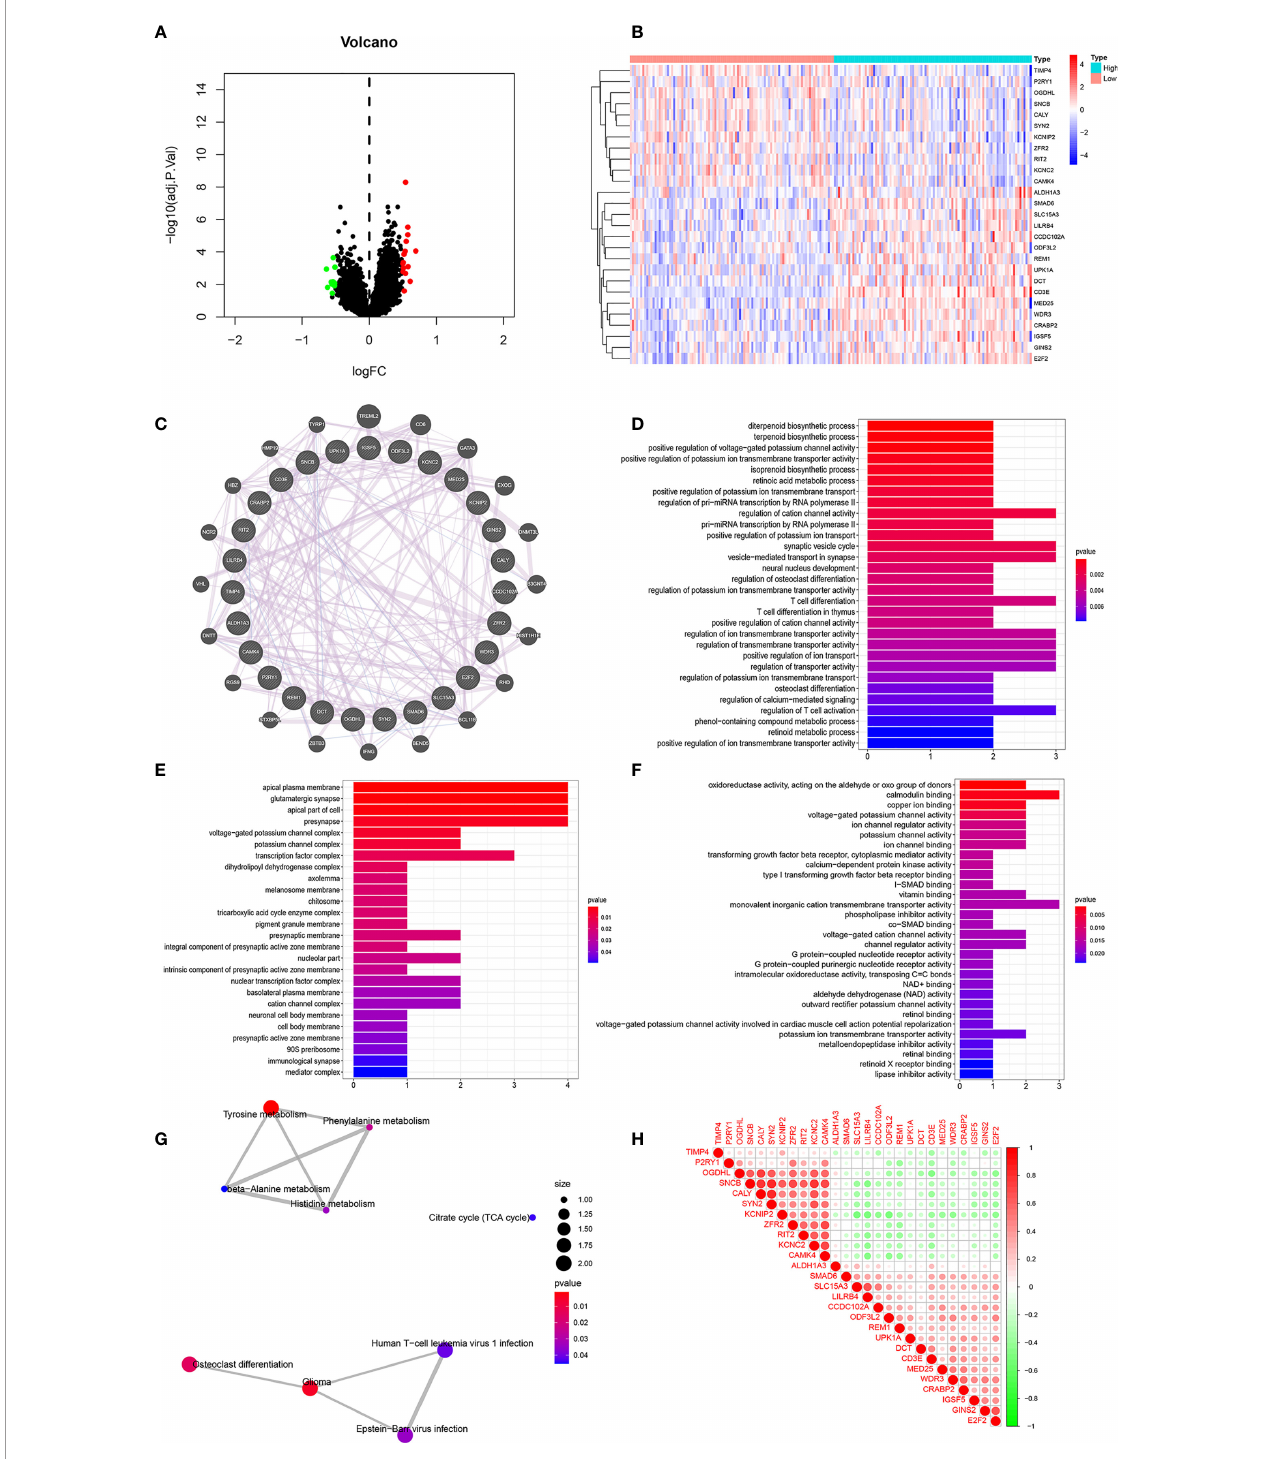
FIGURE 7 | Correlation Analyses of Clinical-Related DEGs (A) The volcano map of Clinical-Related DEGs. (B) The heat map of Clinical-Related DEGs. (C) PPI of Clinical-Related DEGs. co-expression (lavender line), co-localization (deep blue line). (D) The enrichments of biological processes of DEGs. (E) The enrichments of cellular components of DEGs. (F) The enrichments of molecular functions of DEGs. (G) The enrichments in KEGG pathway of DEGs. (H) The 20 most signi fi cantly up-regulated genes and the 20 most signi fi cantly down-regulated genes with CD3E . Red color was for positive correlation, and green color represented a negative correlation. The deeper the color indicated the greater the